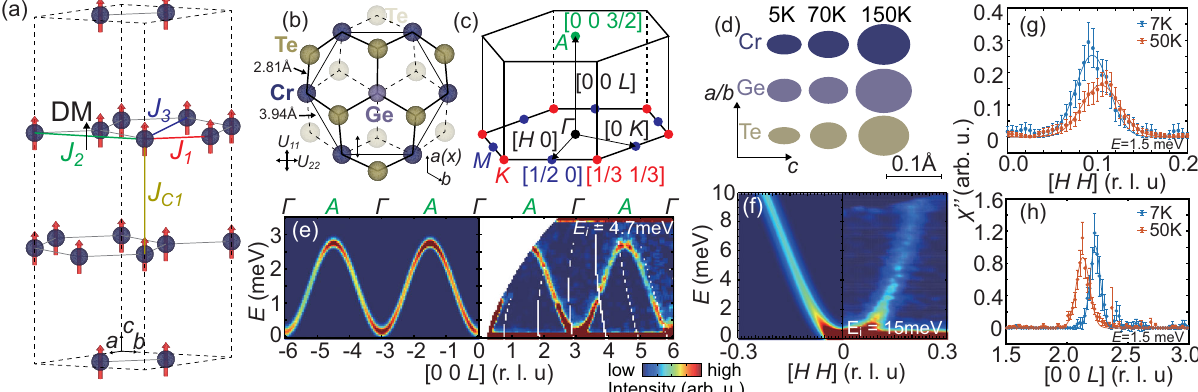
Fig. 1 Real/reciprocal space of CrGeTe 3 and spin waves along the in-plane and c -axis directions. a The hexagonal lattice of CrGeTe 3 , showing only Cr 3 + ions. The magnetic exchange couplings discussed in the main text are shown. b A closer view of the Cr (blue) hexagon together with the ligand Ge (gray) and Te (yellow) atoms. The bold (dashed) lines indicate bonds above (below) the Cr plane, and the Te atoms above (below) the Cr plane are drawn in heavy (light) yellow. The bode length of Cr – Te and Cr – Cr are speci fi ed. c The fi rst Brillouin zone of the hexagonal lattice, high symmetry points Γ (black), M (blue), K (red), and A (green) are indicated. d A schematic picture of the temperature dependence of the root-mean square displacement of atoms in CrGeTe 3 . e Spin waves along the [0, 0, L ] direction. The color scale is applicable to all color plots in this paper. f The low-energy magnons along the [ H , H , 3] direction. The left panels in e , f are the LSWT calculations convoluted with instrumental resolution using parameters given in the main text, and the right panels are experimental results. g , h Imaginary part of the dynamic susceptibility along the g [ H , H ] and h [0, 0, L ] directions at different temperature. The error bars in g , h represent statistical errors of 1 standard